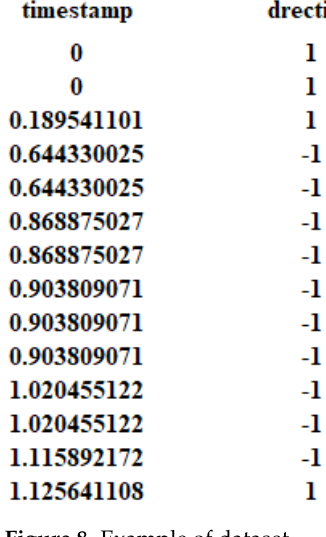
Figure 8. Example of dataset.